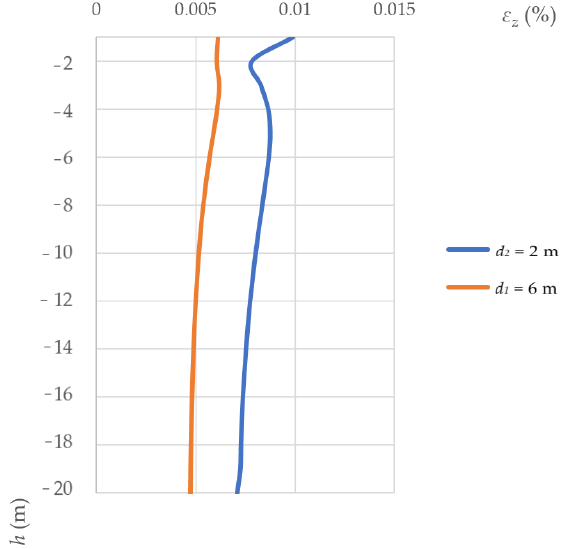
Figure 9. Diagrams of vertical strains ε y along the vertical line at distances d 1 = 6 m and d 2 = 2 m.